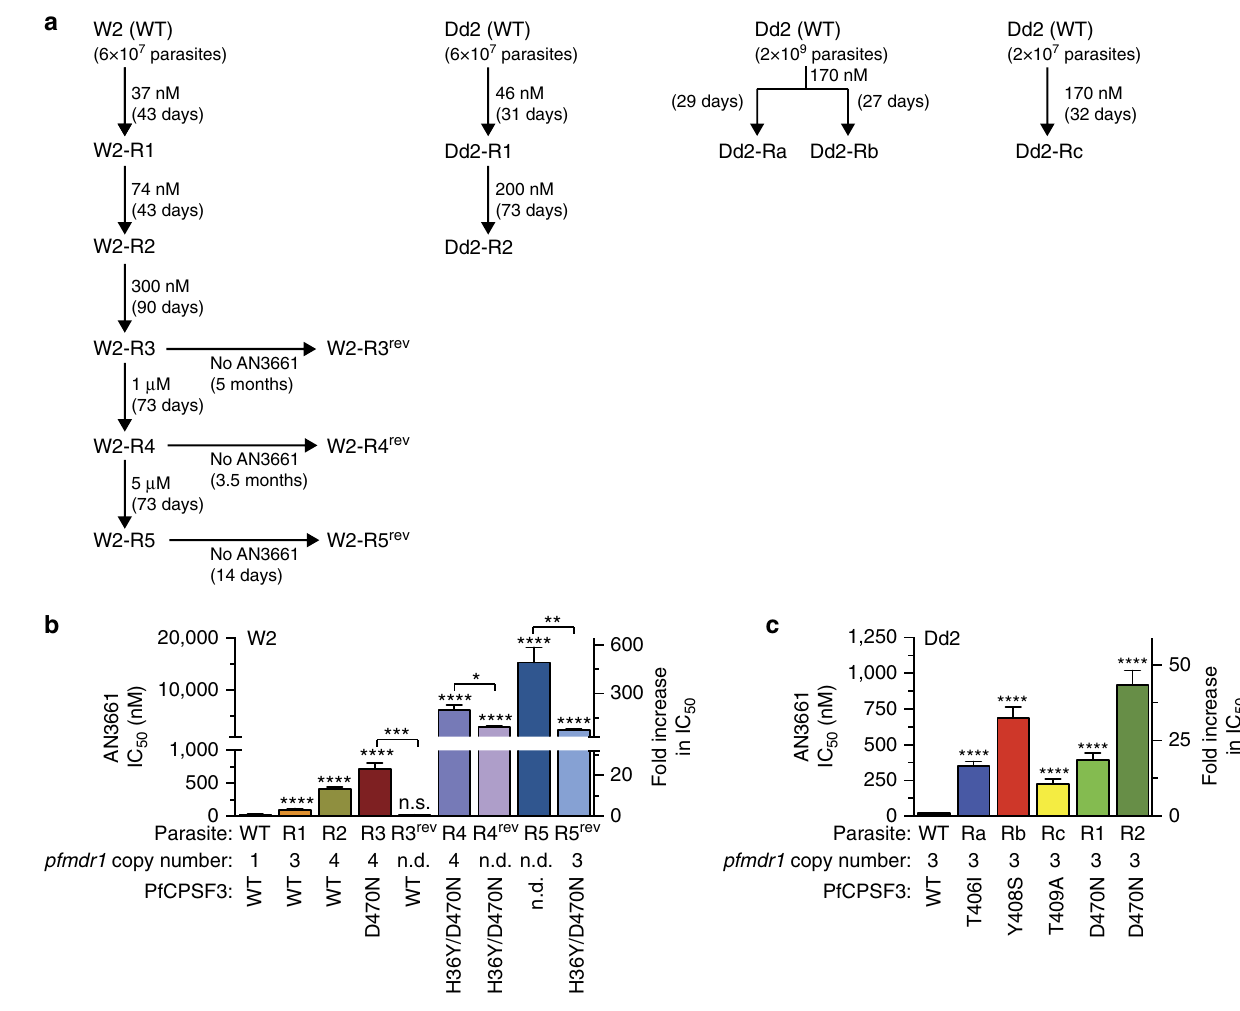
Figure 4 | AN3661 susceptibility of drug-pressured P. falciparum parasites. ( a ) Selection process of W2 and Dd2 parasites subjected to AN3661 at either a single concentration or increasing concentrations over time. ( b ) Susceptibility to AN3661 of W2-strain wild-type (WT) and drug-pressured lines (replicates: WT, 13; W2-R1, 6; W2-R3, 3; W2-R3 rev , 3; W2-R4, 6; W2-R4 rev , 3; W2-R5, 2; W2-R5 rev , 3). ( c ) Susceptibility to AN3661 of Dd2 strain WTand drug-pressured lines (replicates: WT, 27; Dd2-Ra, 9; Dd2-Rb, 11; Dd2-Rc, 3; Dd2-R1, 3; and Dd2-R2, 3). For all assays, details are in Supplementary Table 1, bar graphs represent mean ± s.e.m. IC 50 values, and pfmdr1 copy numbers are indicated for each parasite line. Significance was determined using a two-tailed unpaired t -test, comparing drug-pressured parasites to parental strains, unless otherwise indicated. * P o 0.05, ** P o 0.005, *** P o